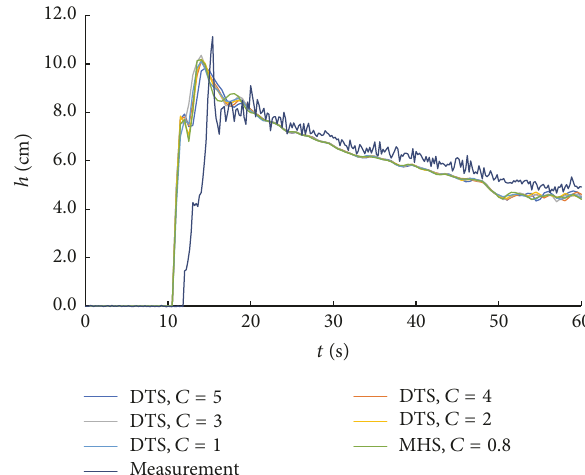
Figure 6: Comparison of numerical results with different Courant number in the station